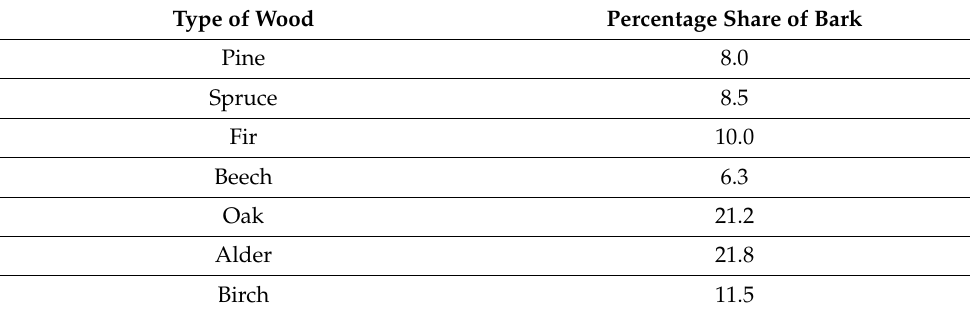
Table 2. Percentage share of bark in long wood. Type of